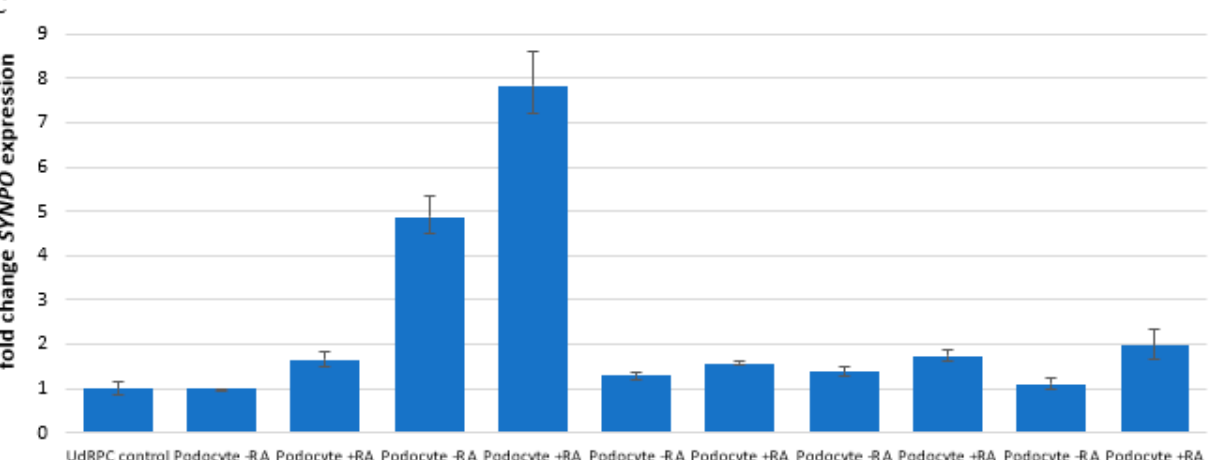
Figure 1. Derivation of mature and functional podocytes from human urine-derived renal progenitor cells. The self-renewal capacity of UdRPCs is maintained by proliferation medium. Differentiation of UdRPCs into podocytes is induced by low density cultivation in adv. RPMI supplemented with 30 µ M retinoic acid ( A ). Expression of the podocyte associated genes NPHS1 ( B ) and SYNPO ( C ) was determined by quantitative real-time PCR.